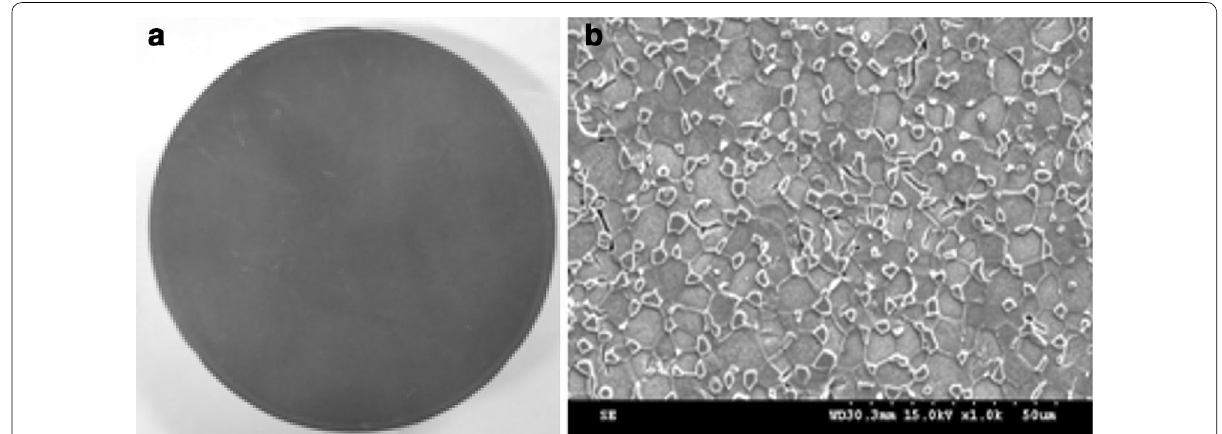
Fig. 4 a Photograph and b SEM observation of sputtering target made of reused ITO‑NPs heat‑treated at 980